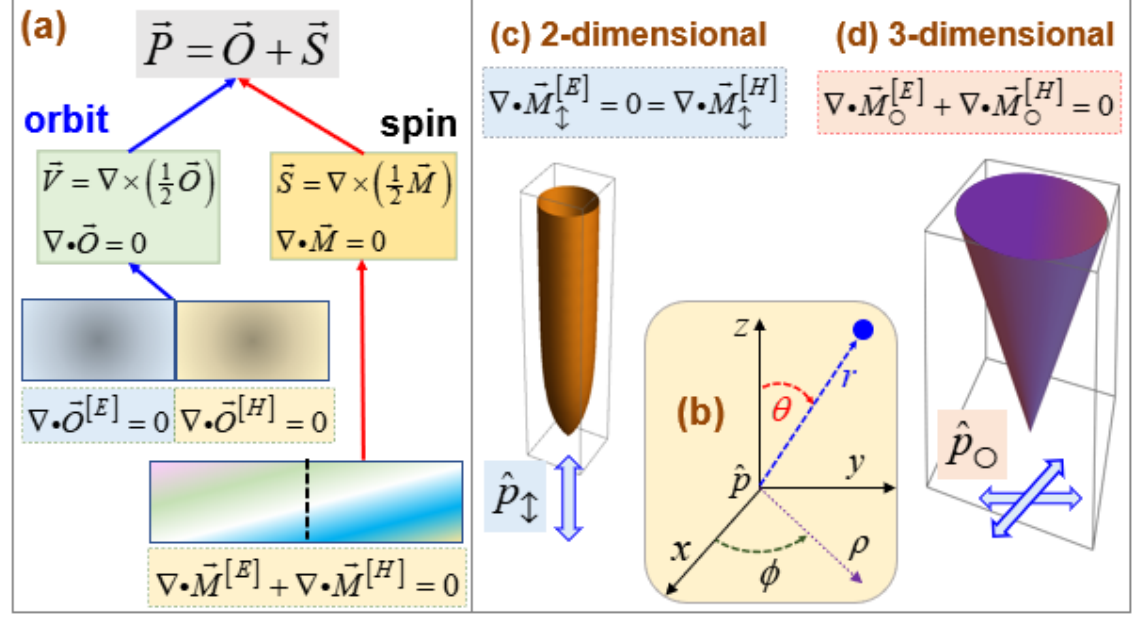
Figure 1. ( a ) Decomposition of a Poynting vector P into an orbital energy flux O and a spin energy flux S . Besides, M is a spin angular momentum (SAM) density. ( b ) The coordinate systems. On the origin lies a primary electric point dipole represented by its unit vector ˆ p . ( c ) A linear dipole ˆ p with its dipole axis lying parallel to the vertical axis leads to a pencil-hull-like tapered cylindrical surface designating higher values for the degree of circular polarization (DoCP). ( d ) A circular dipole ˆ p with its dipole axis lying on the horizontal plane leads to a filled solid cone of higher values of DoCP.